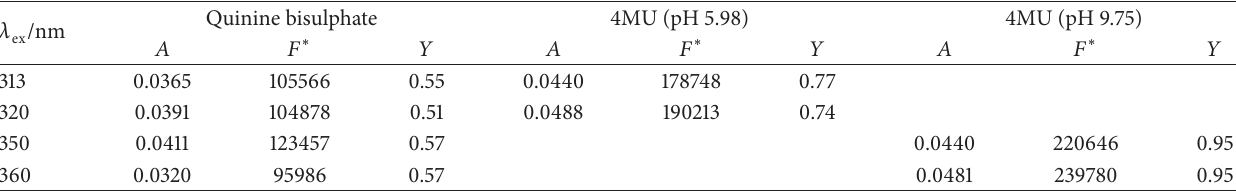
Table 2: Measurement of fluorescence quantum yield of 4MU in different